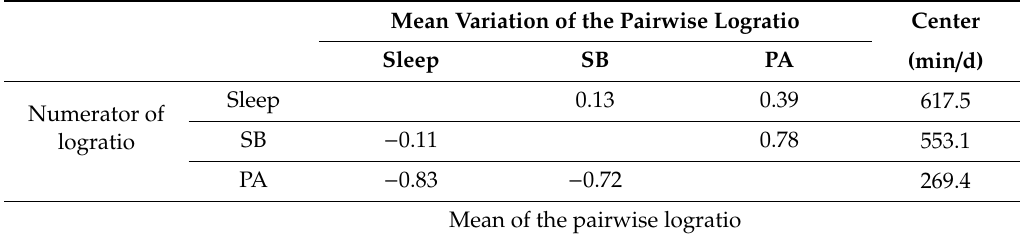
Table 1. Variation array of three-part time-use composition. Mean Variation of the Pairwise